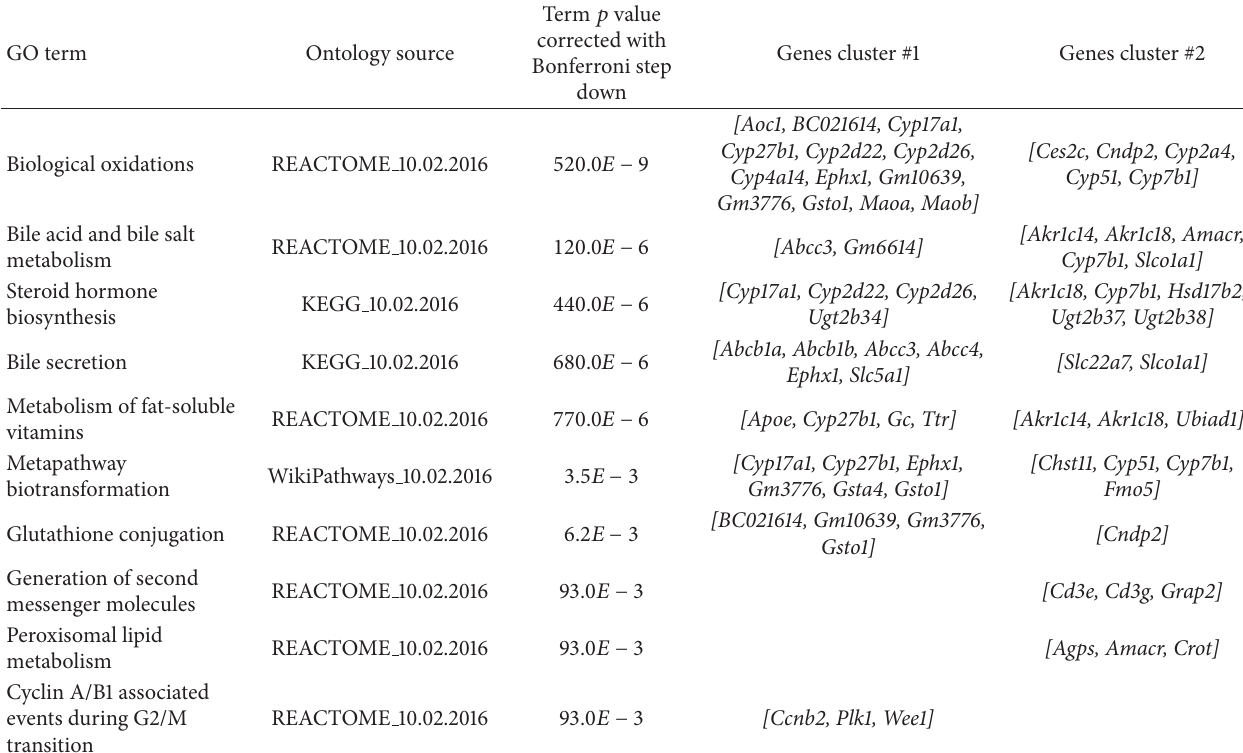
Table 3: Top 10 enriched pathway terms of DEGs sorted by 𝑝 value